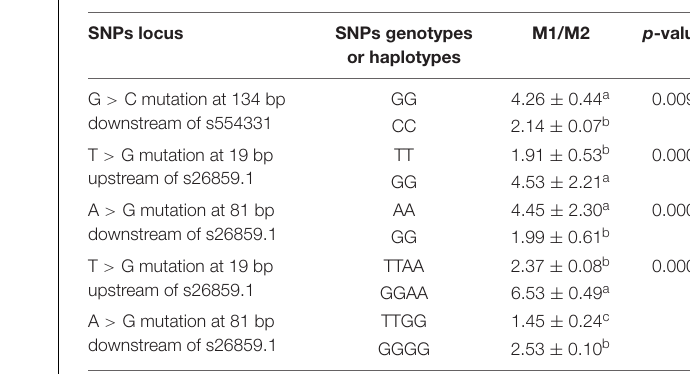
TABLE 4 | Effects of genotypes or haplotypes of candidate functional SNPs on dual-luciferase